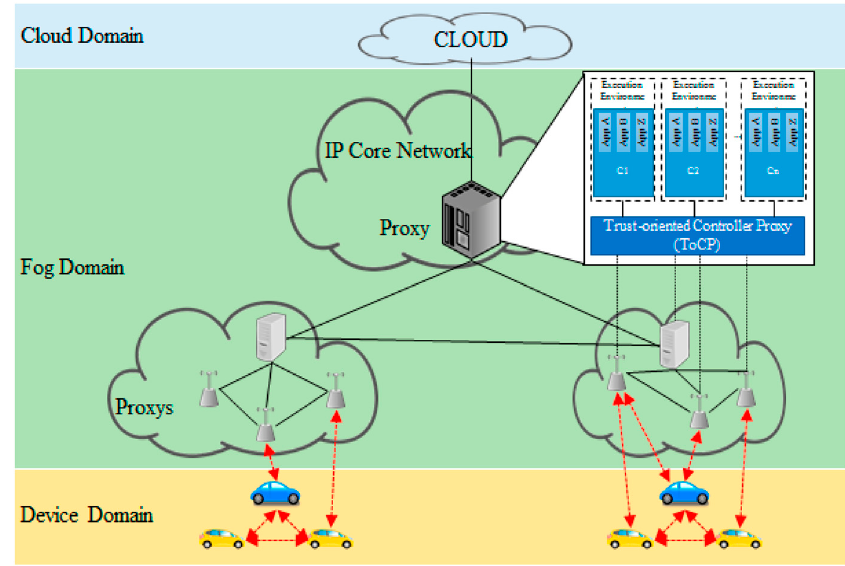
Figure 3. SDN-based VANET.